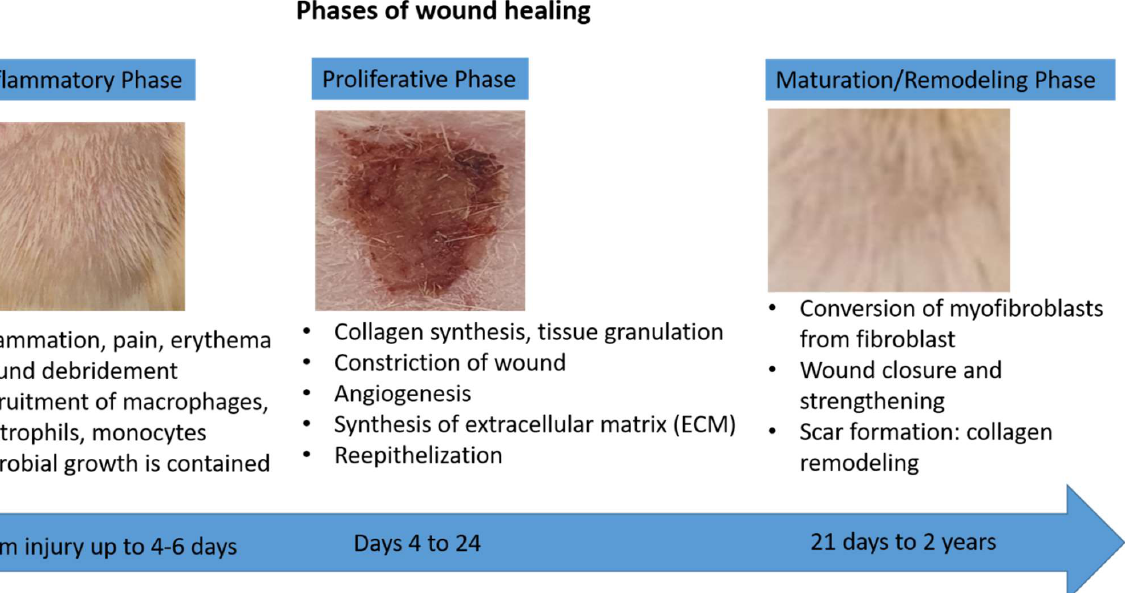
Table S4: Raw data of NAP3 assay; Table S5: Raw data of MPO assay